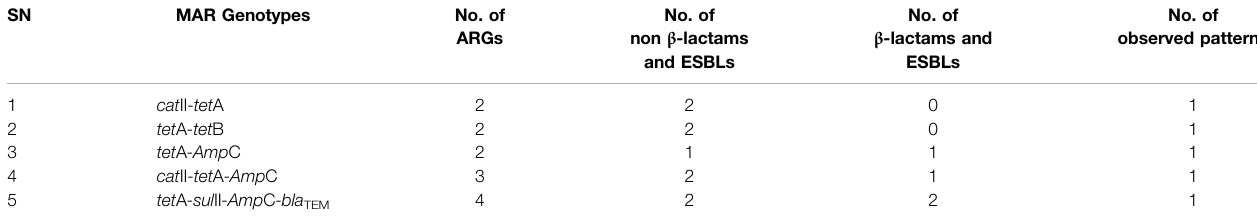
TABLE 5 | The MARGs of the pathogenic strains of E. coli recovered from agricultural soil. SN